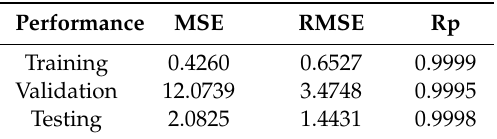
Table 15. Performance of the ANN model for the dry